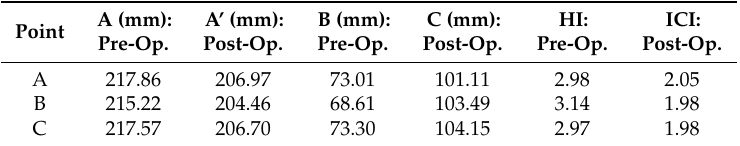
Table 5. Haller index values before and after the Nuss procedure in Patient No. 1.